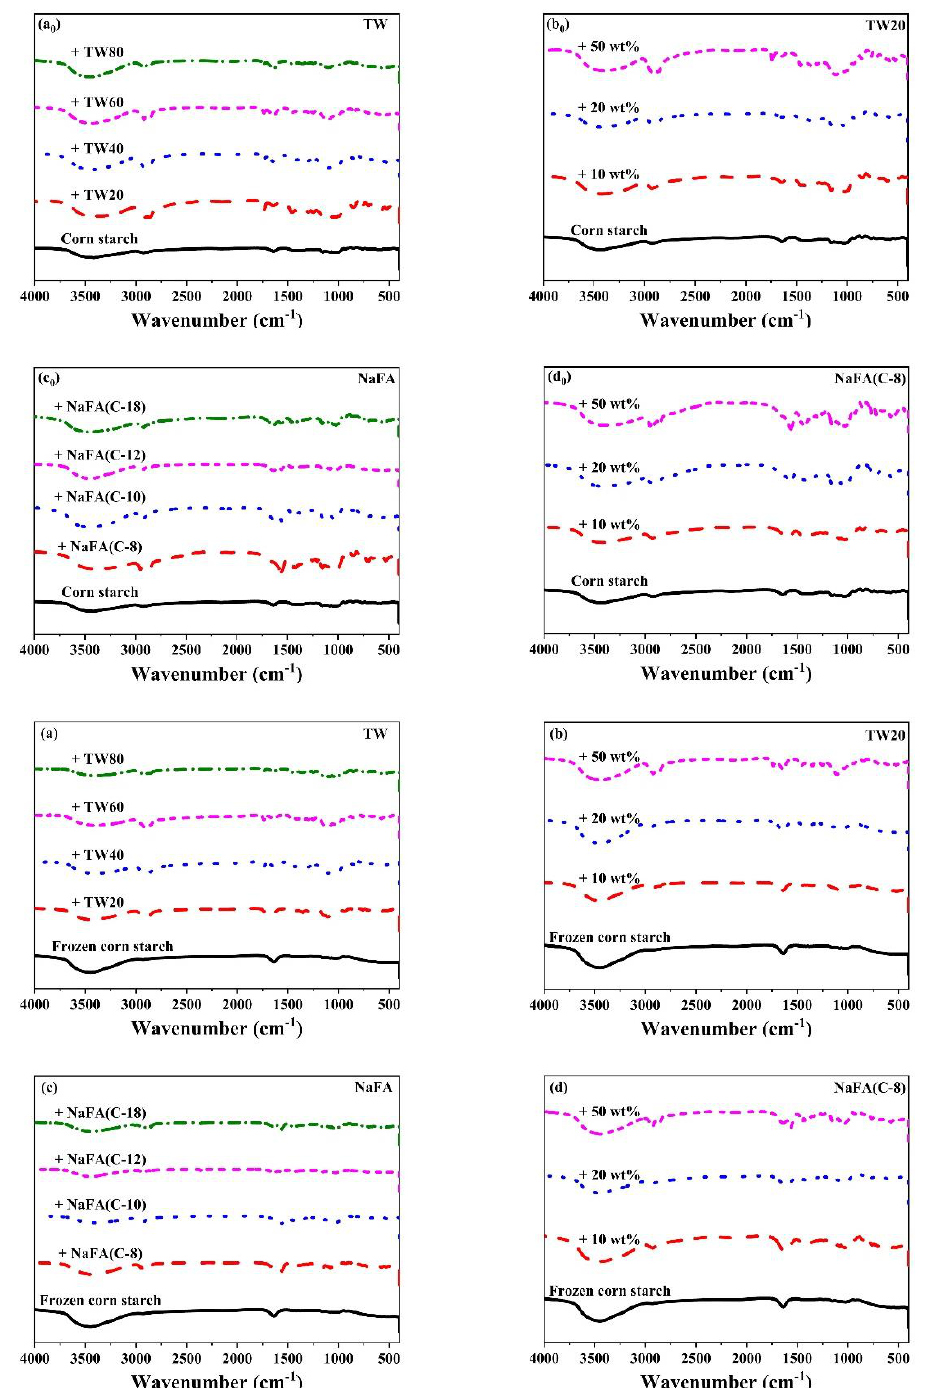
Figure 4. FT-IR spectra of regular ( a 0 – d 0 ) or frozen ( a – d ) corn starch in the presence of Tween (TW) and sodium fatty acid (NaFA). ( a 0 , a ) FT-IR spectra of corn starch in the presence of different types of TW (50 wt%). ( b 0 , b ) FT-IRspectra of corn starch in the presence of different concentrations of TW20. ( c 0 , c ) FT-IR spectra of corn starch in the presence of different types of NaFA (50 wt%). ( d 0 , d ) FT-IR spectra of corn starch in the presence of different concentrations of NaFA (C-8). The infrared peak range of 1065 – 950 cm −1 is the fingerprint region that characterizes the conformation changes and ordered double helix structure of the starch [33]. The ratio of peak strength at 1047 to 1022 cm −1 (I 1047/1022 ) reflects the relative content between the ordered and amorphous structures of starch. Figure 5 shows the I 1047/1022 of freeze-dried corn starch paste which was mixed with TW or NaFA. For both surfactants, I 1047/1022